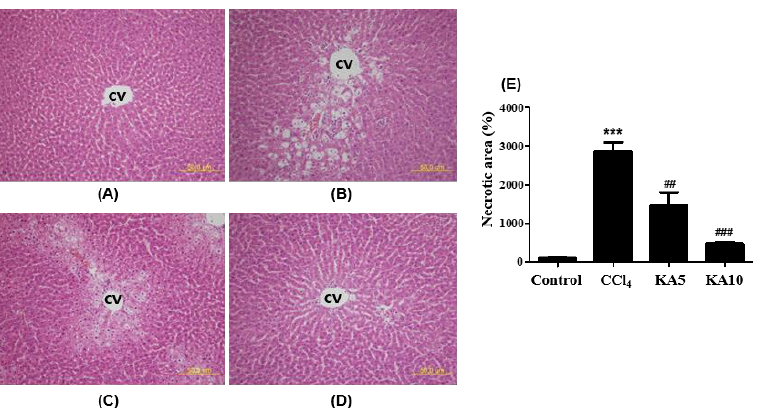
Figure 4. Effects of kaempferol on CCl 4 -induced histopathological changes in rat livers. H&E staining of liver sections from: ( A ) Control rats; ( B ) CCl 4 -treated rats; ( C ) CCl 4 -treated rats with kaempferol (5 mg/kg); ( D ) CCl 4 -treated rats with kaempferol (10 mg/kg). ( E ) Quantitative analysis of necrotic area observed on H&E-stained sections. *** p < 0.001 vs. the control group, ## p < 0.01 and ### p < 0.001 vs. the CCl 4 group. CV: central vein. All images are original magnification ×400.